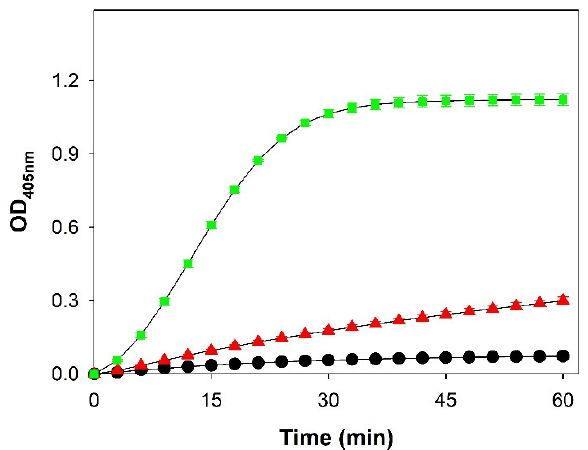
Figure 4. Enzymatic activity in the absence of added ions of HSA (black circles), PPA (red triangles) and AOA (green squares), measured as the absorbance increase in the various amylase solution at 405 nm.